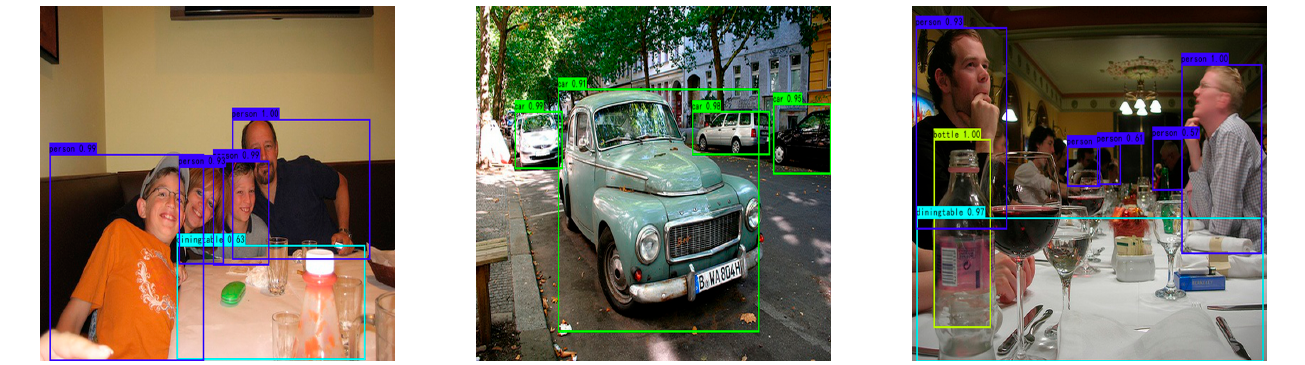
Figure 10. Detection examples of YOLOv3-NAB on various datasets.